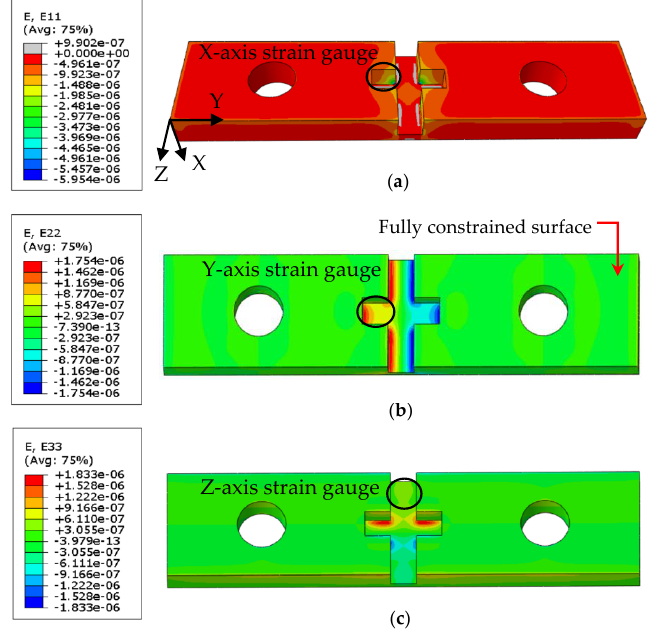
Figure 9. Simulation results for ( a ) X -axis strain results from the force in the X direction, ( b ) Y -axis strain results from the force in the Y direction, and ( c ) Z -axis strain results from the force in the Z